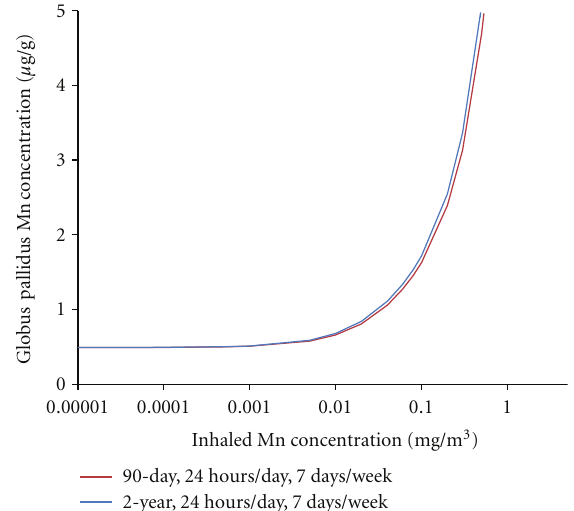
Figure 7: Simulated end-of-exposure nonhuman primate globus pallidus manganese concentrations following a 24 h/d, 7d/wk inhalation for either 90 days (subchronic) or 2yr (chronic) exposure to MnSO 4 . These simulations indicate that globus pallidus manganese concentrations are expected to rapidly reach pseudosteady-state levels during high dose manganese exposure, and that duration of exposure has a minimal e ff ect. Its contribution only occurs once exposures reach the threshold to cause tissue